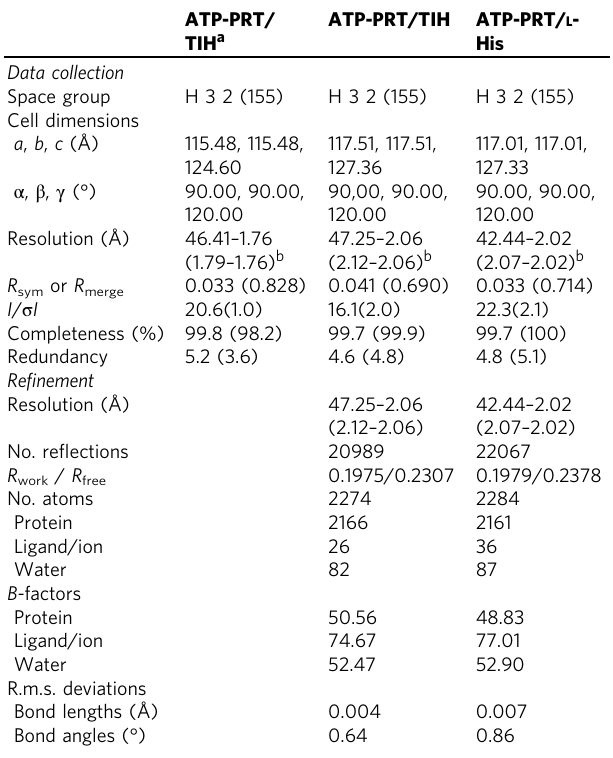
Table 3 Data collection and re fi nement statistics (molecular